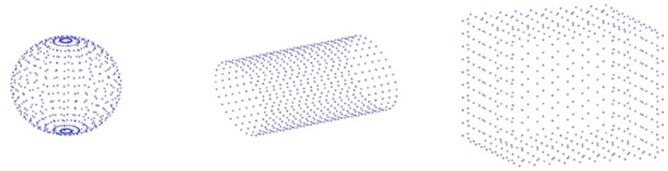
Figure 6. A 3D model and its corresponding point cloud data.